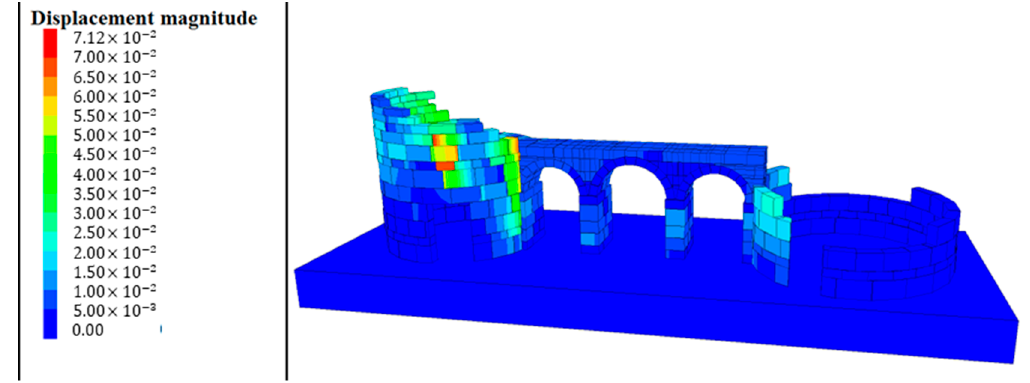
Figure 11. Displacement magnitude under Dinar, Turkey 1995 earthquake .